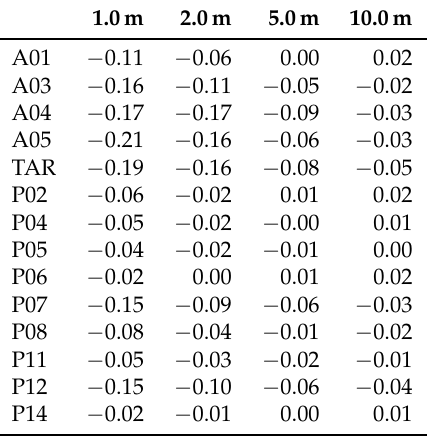
Table 4. Mean deviations [m] of different digital water surface models from the reference water level for the 99%